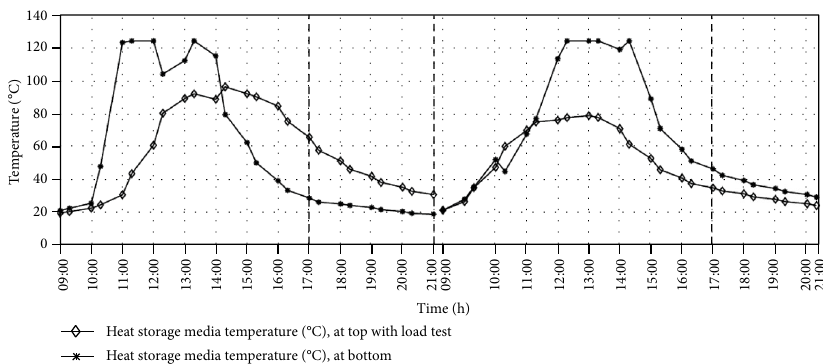
Figure 11: Variance of heat storage medium temperature of load drying tests on the top and bottom side with time.